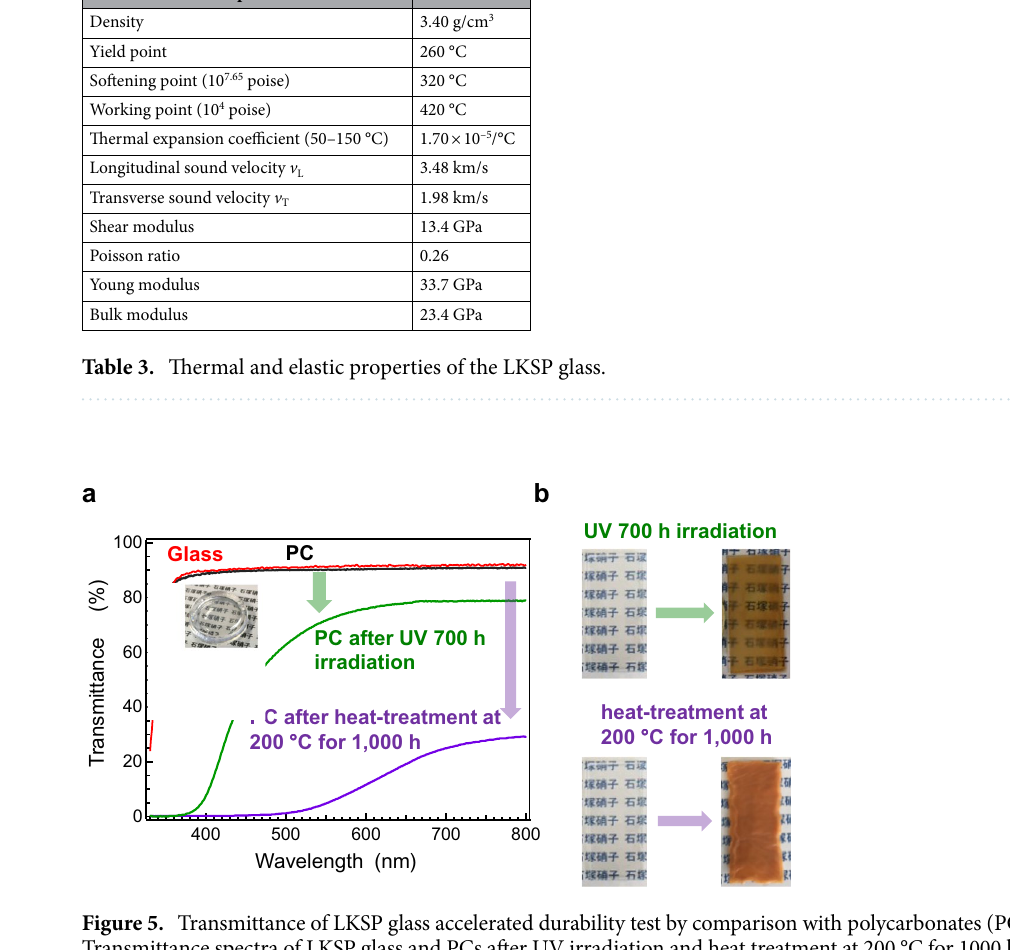
Figure 5. Transmittance of LKSP glass accelerated durability test by comparison with polycarbonates (PCs). ( a ) Transmittance spectra of LKSP glass and PCs after UV irradiation and heat treatment at 200 °C for 1000 h. ( b ) Photographs of PCs before and after durability tests. Remarkable transmittance degradation is observed in PCs, while no change is observed in the LKSP